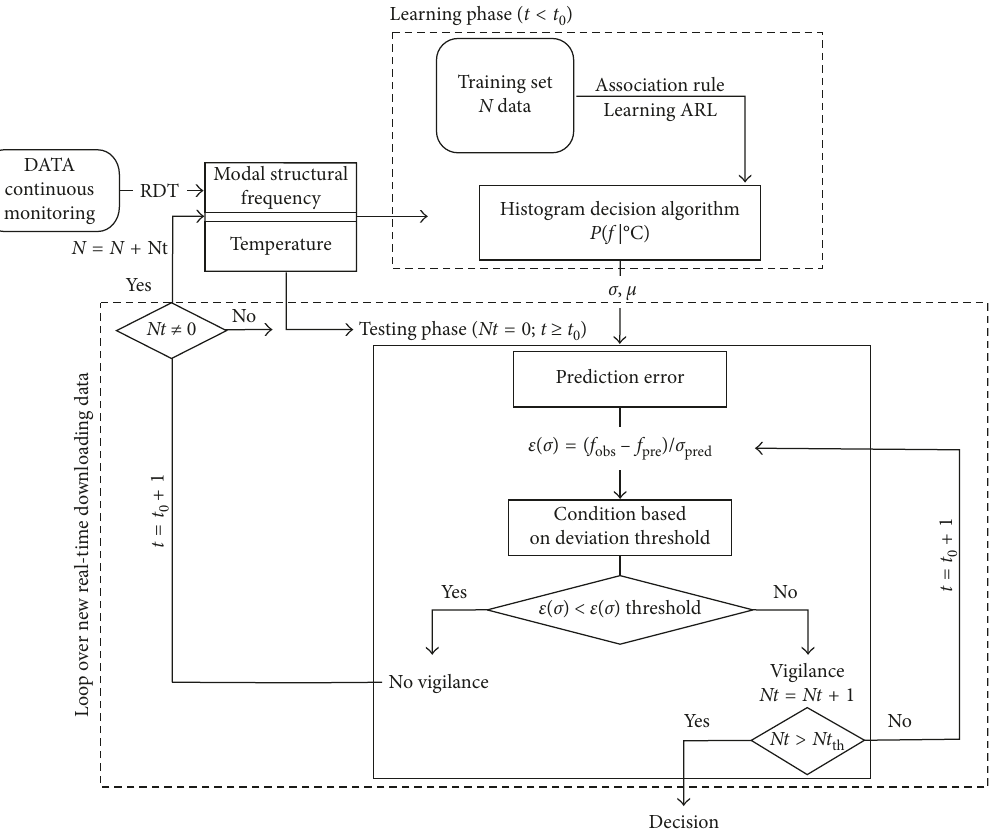
Figure 2: Flowchart of the condition-based decision using {frequency-temperature}